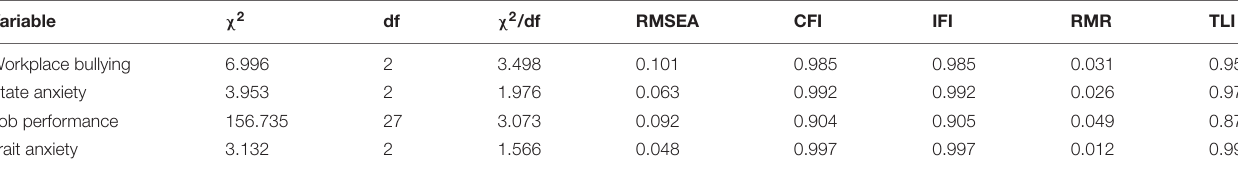
TABLE 1 | Confirmatory factor analysis.